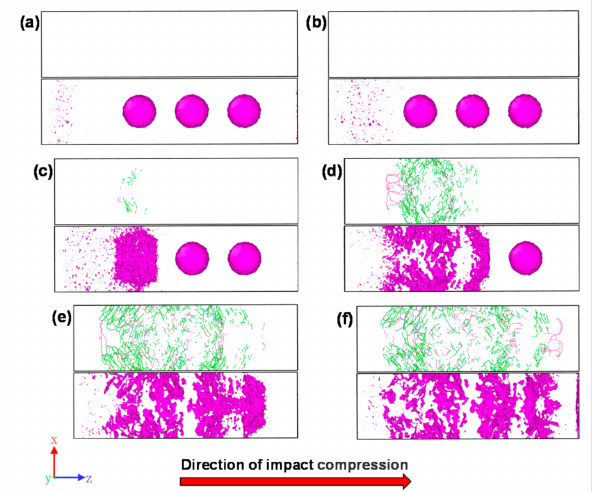
Figure 6. Evolution of voids and dislocations in porous samples during compression: ( a ) 1.5 ps; ( b ) 3.0 ps; ( c ) 4.5 ps; ( d ) 6.5 ps; ( e ) 9.0 ps; ( f ) 10 ps (pink is <100> dislocation, blue is <110> dislocation, green is 1 / 2 <111> dislocation, and red is other